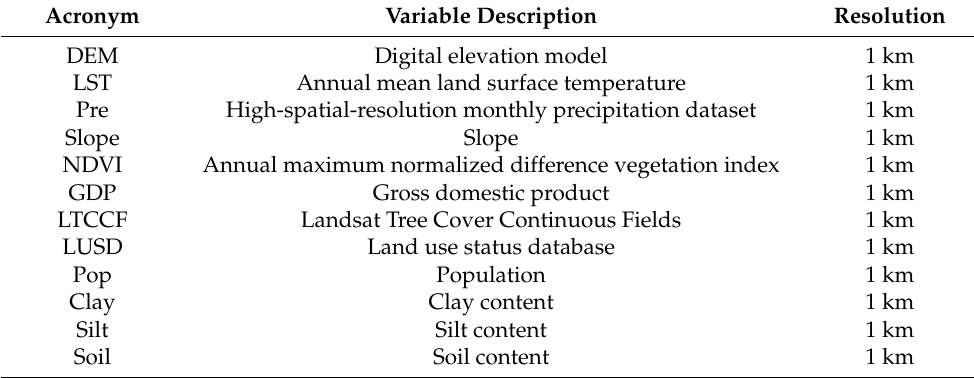
Table 1. Variables and their